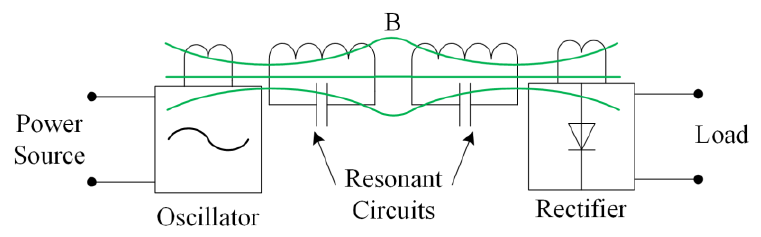
Figure 4. Basic structure schematic diagram of WPT via magnetically-coupled resonance.